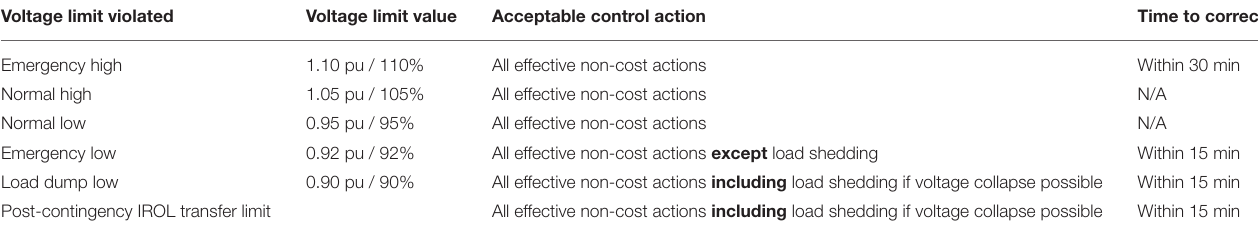
TABLE 3 | Acceptable actions and timeline for simulated post-contingency voltage violations.